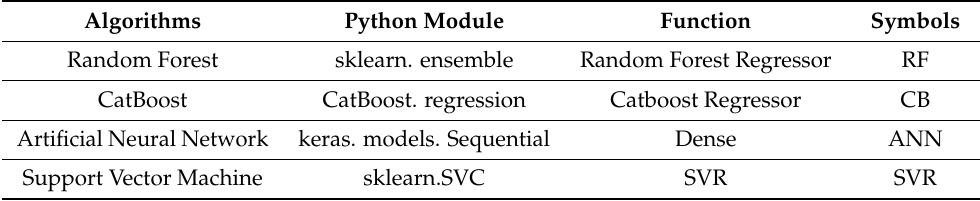
Artificial Neural Network keras. models. Sequential Table 2. The ML models description used for the experiments in python.